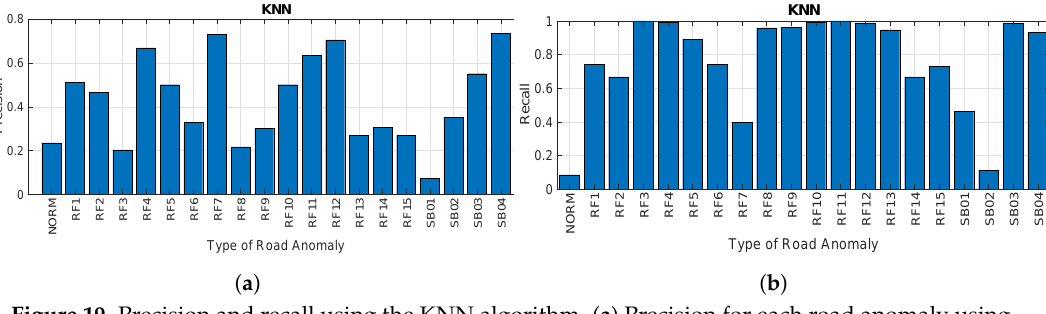
Figure 19. Precision and recall using the KNN algorithm. ( a ) Precision for each road anomaly using KNN (sampling rate of 50 Hz) and ( b ) recall for each road anomaly using KNN (sampling rate of 50